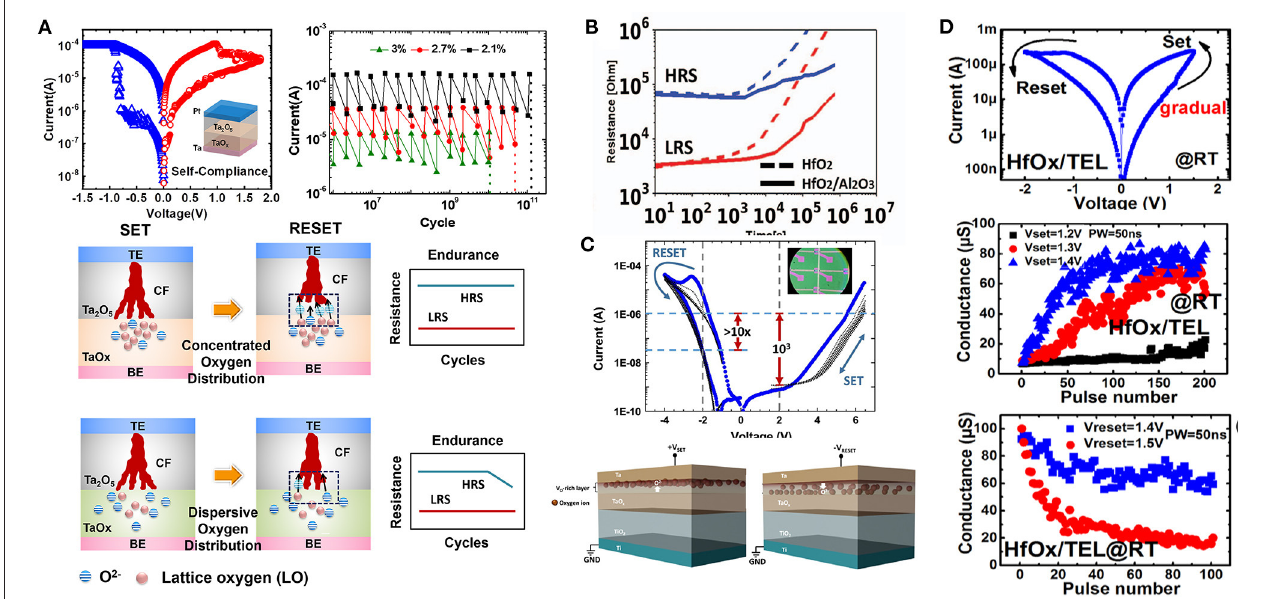
FIGURE 2 | (A) The self-compliance and enhanced endurance characteristics of Ta 2 O 5 /TaO X -based RRAM and its schematic endurance model. (B) The retention characteristics at 200 ◦ C of the HfO 2 /Al 2 O 3 device and its comparison with the single-layer HfO 2 device. (C) Self-rectifying characteristics in the TaOx/TiO 2 -based RRAM with 10 3 rectifying ratio and the schematic mechanism. (D) Analog switching behavior under both SET and RESET pulses in the HfOx/TaOx RRAM. Reprinted from Lee et al. (2011), Azzaz et al. (2015), Chou et al. (2015), Zhao et al. (2015, 2016), Wu W. et al.